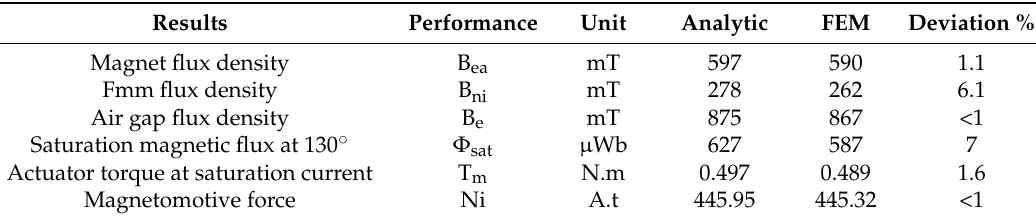
Table 2. Linear magnetics results of optimized actuator.